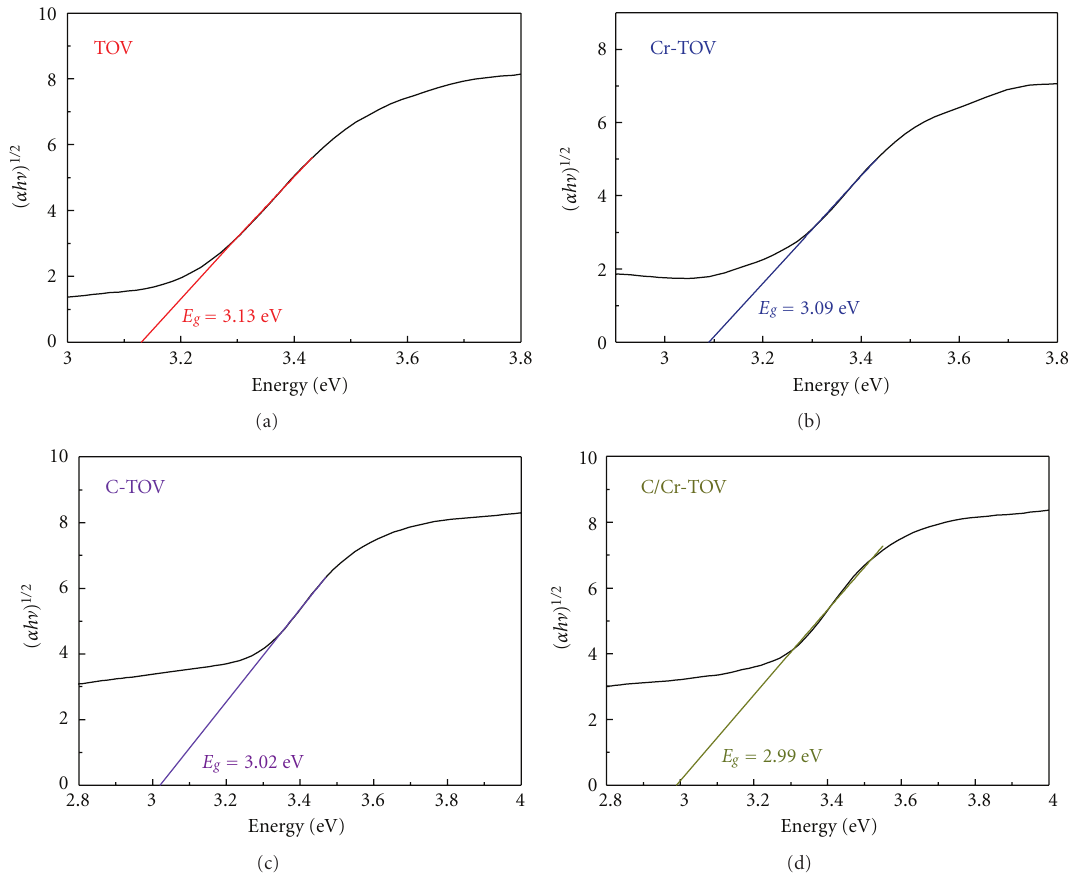
Figure 3: The plot of ( αhv ) 1 / 2 versus photon energy of the samples with di ff erent oxygen